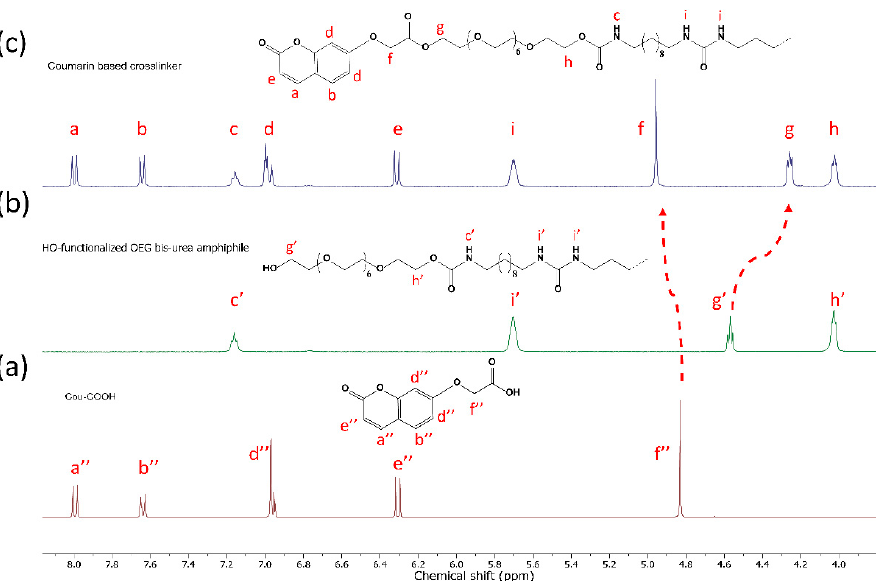
Figure 2. 1 H NMR spectra of Cou-COOH ( a ), HO-functionalized OEG bis-urea amphiphile ( M8-10 OH ) ( b ), and coumarin based crosslinker ( Cou-crosslinker ) ( c ) in d 6 -DMSO. OH ) ( b ), and coumarin based crosslinker ( Cou-crosslinker ) ( c ) in d 6